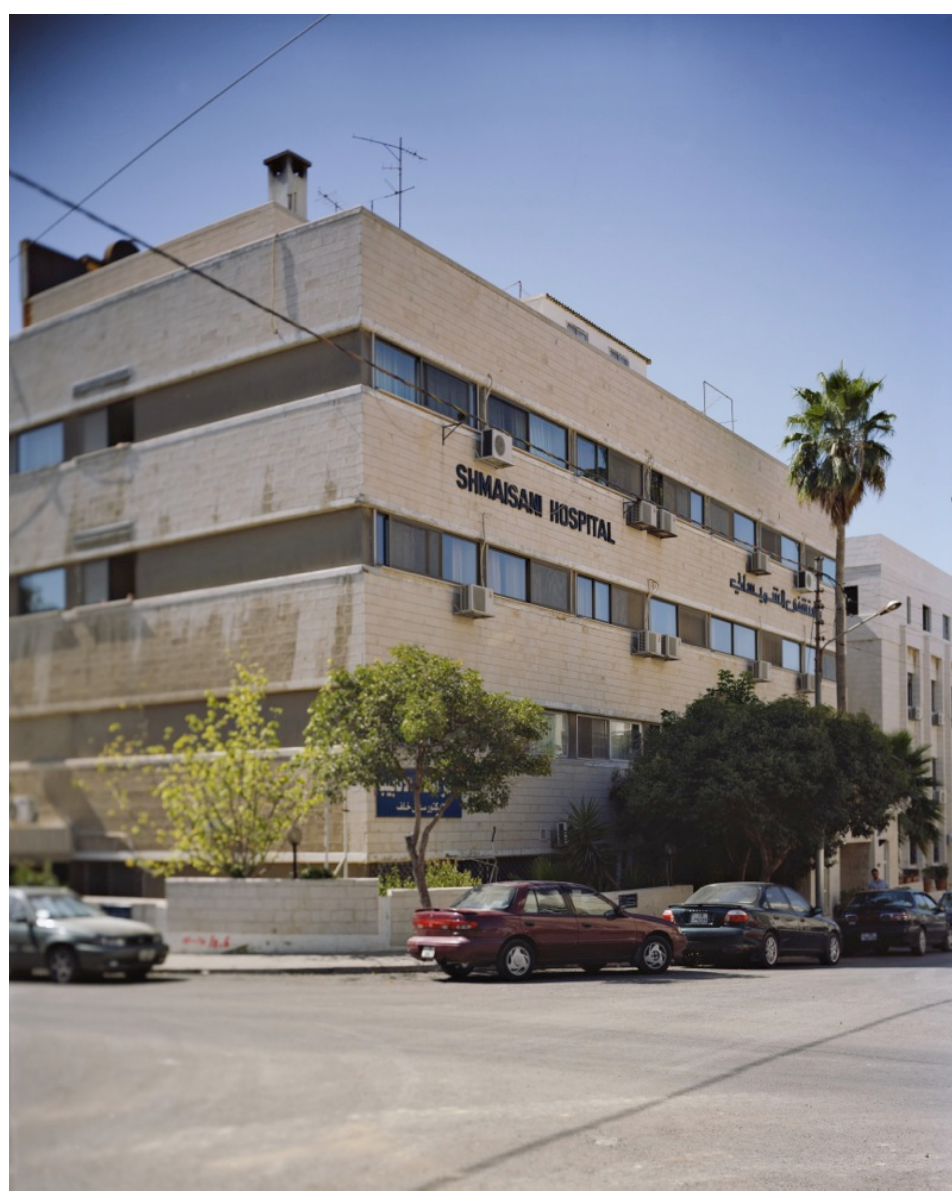
Regina Mamou, Untitled (Shmeisani Hospital) from the series Mapping Collected Memory , 2009–2010. Digital C-print. 40 x 32 in. (101.60 x 81.28